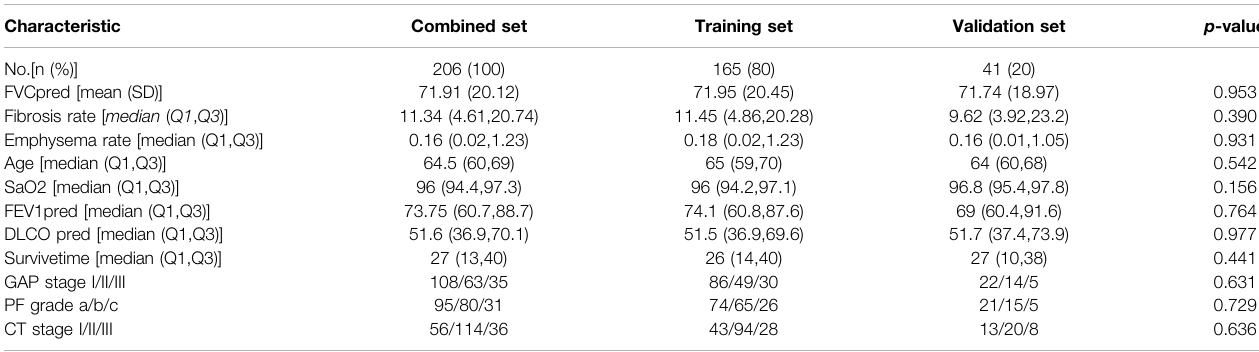
TABLE 4 | Patients ’ clinical characteristics of the training set and validation set. Characteristic Combined set Training set Validation set p -value